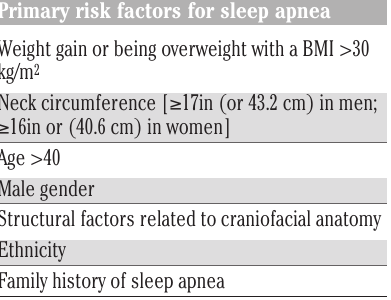
Table 1. Primary risk factors for obstruc- tive sleep apnea. Primary risk factors for sleep apnea Weight gain or being overweight with a BMI >30 kg/m 2 Neck circumference [ ≥ 17in (or 43.2 cm) in men;